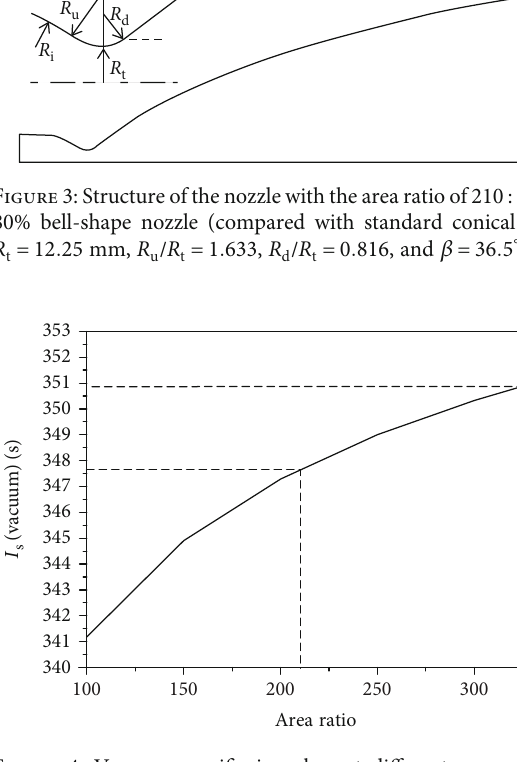
Figure 4: Vacuum speci fi c impulses at di ff erent area ratios. To increase the I ( arearatio = 210 : 1 ) by 3s, the area ratio should sv be increased to 325:1 at